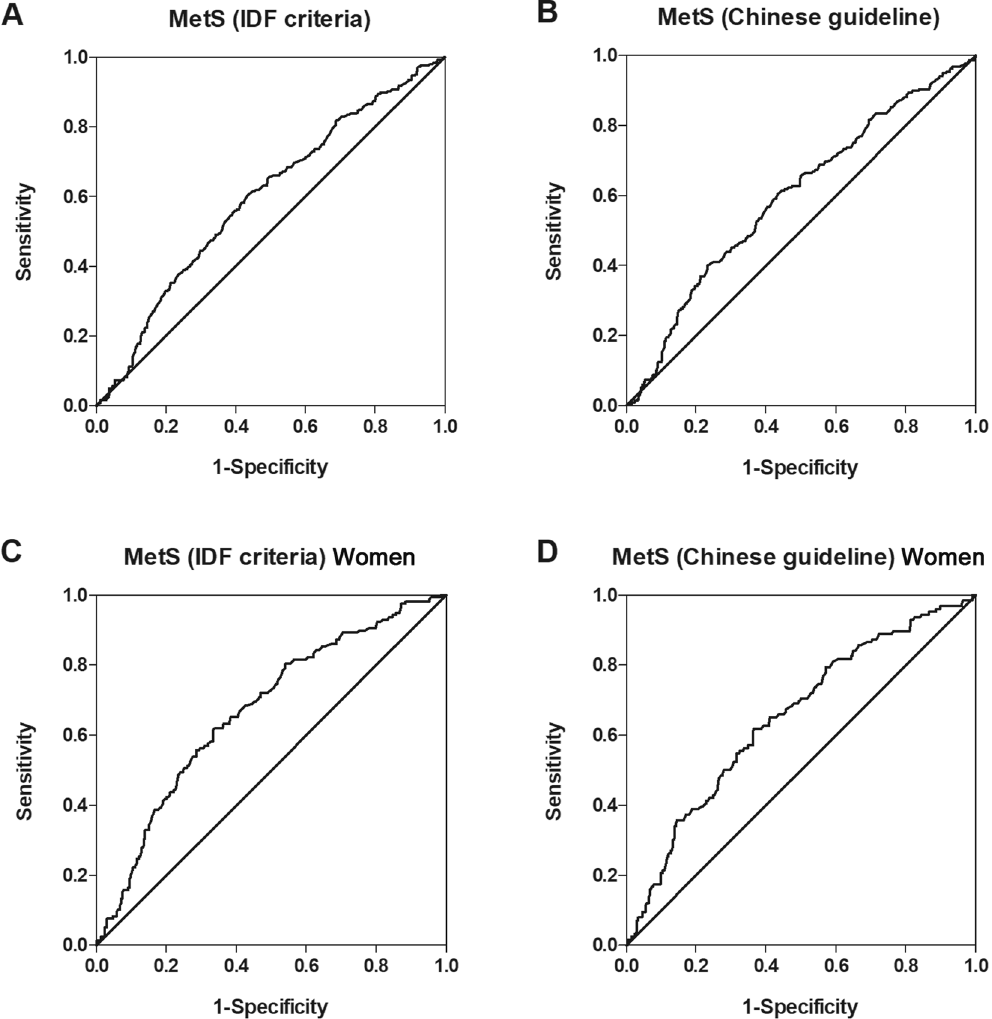
Figure 1. ROC curves of SUA level predicting MetS. ( A) SUA level predicting MetS according to the IDF criteria in the very elderly. The AUC value was 0.622 (95%CI: 0.581–0.663, p < 0.001). ( B) SUA level predicting MetS according to the Chinese guideline in the very elderly. The AUC value was 0.606 (95%CI: 0.563–0.649, p < 0.001). ( C) SUA level predicting MetS according to the IDF criteria in very elderly women. The AUC value was 0.669 (95%CI: 0618–0.721, p < 0.001). ( D) SUA level predicting MetS according to the Chinese guideline in very elderly women. The AUC value was 0.650 (95%CI: 0.594–0.706, p < 0.001). AUC: area under curve,